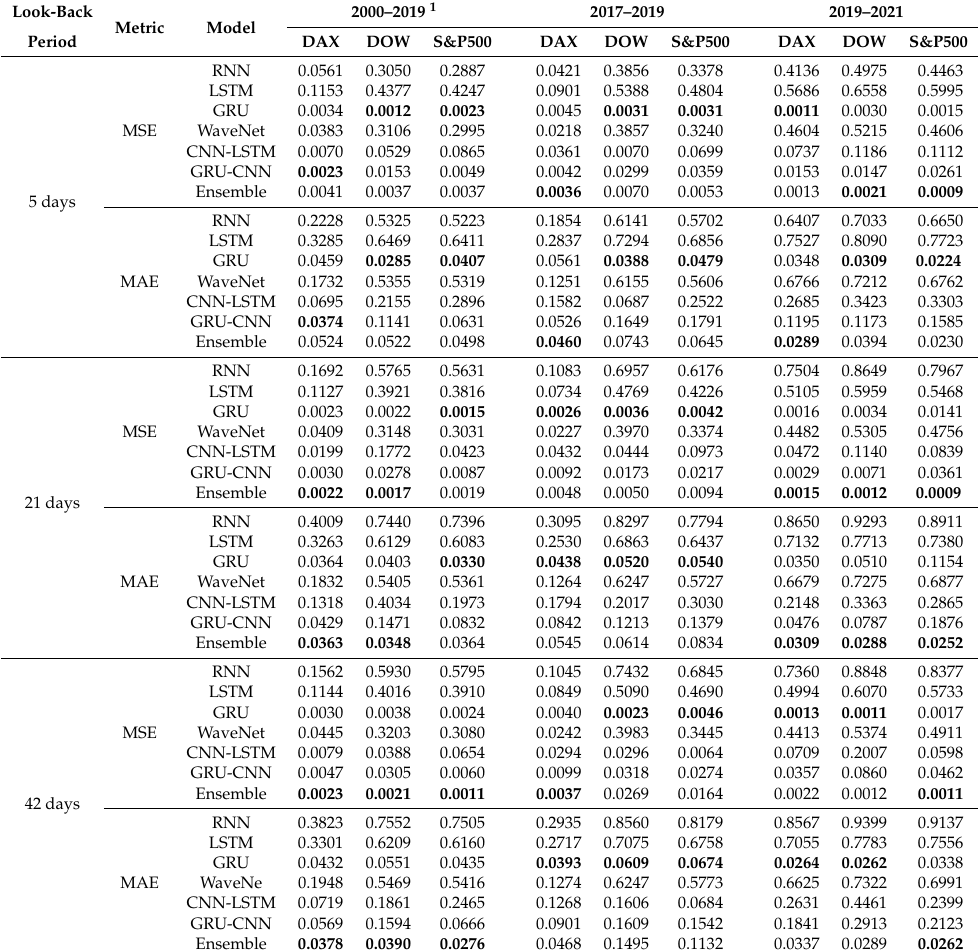
Table 6. Comparison of five-time-step prediction between proposed and benchmark models. Look-Back Metric